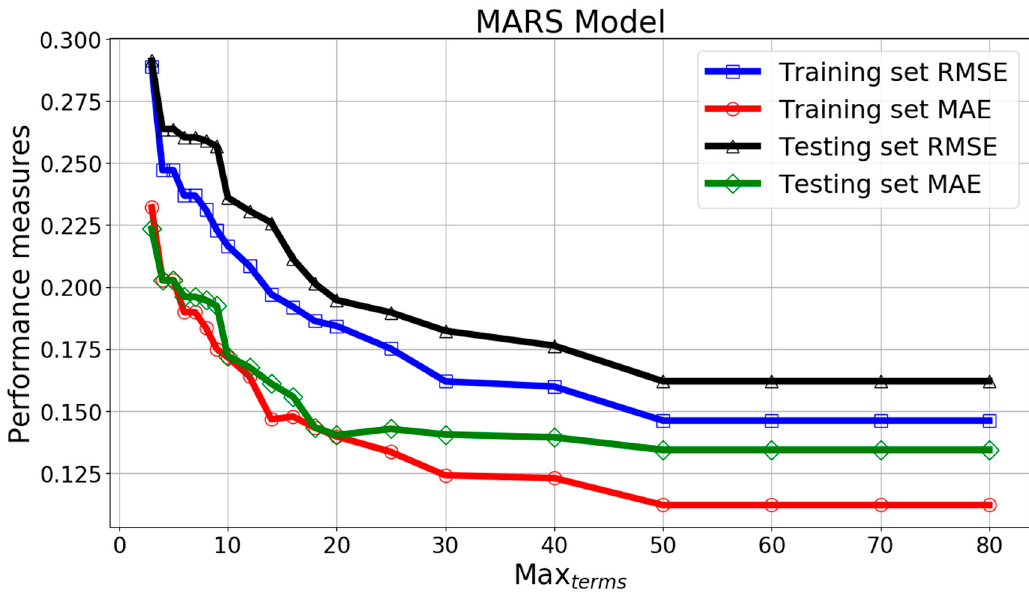
Figure 28. RMSE and MAE versus parameter Max terms for MARS model.